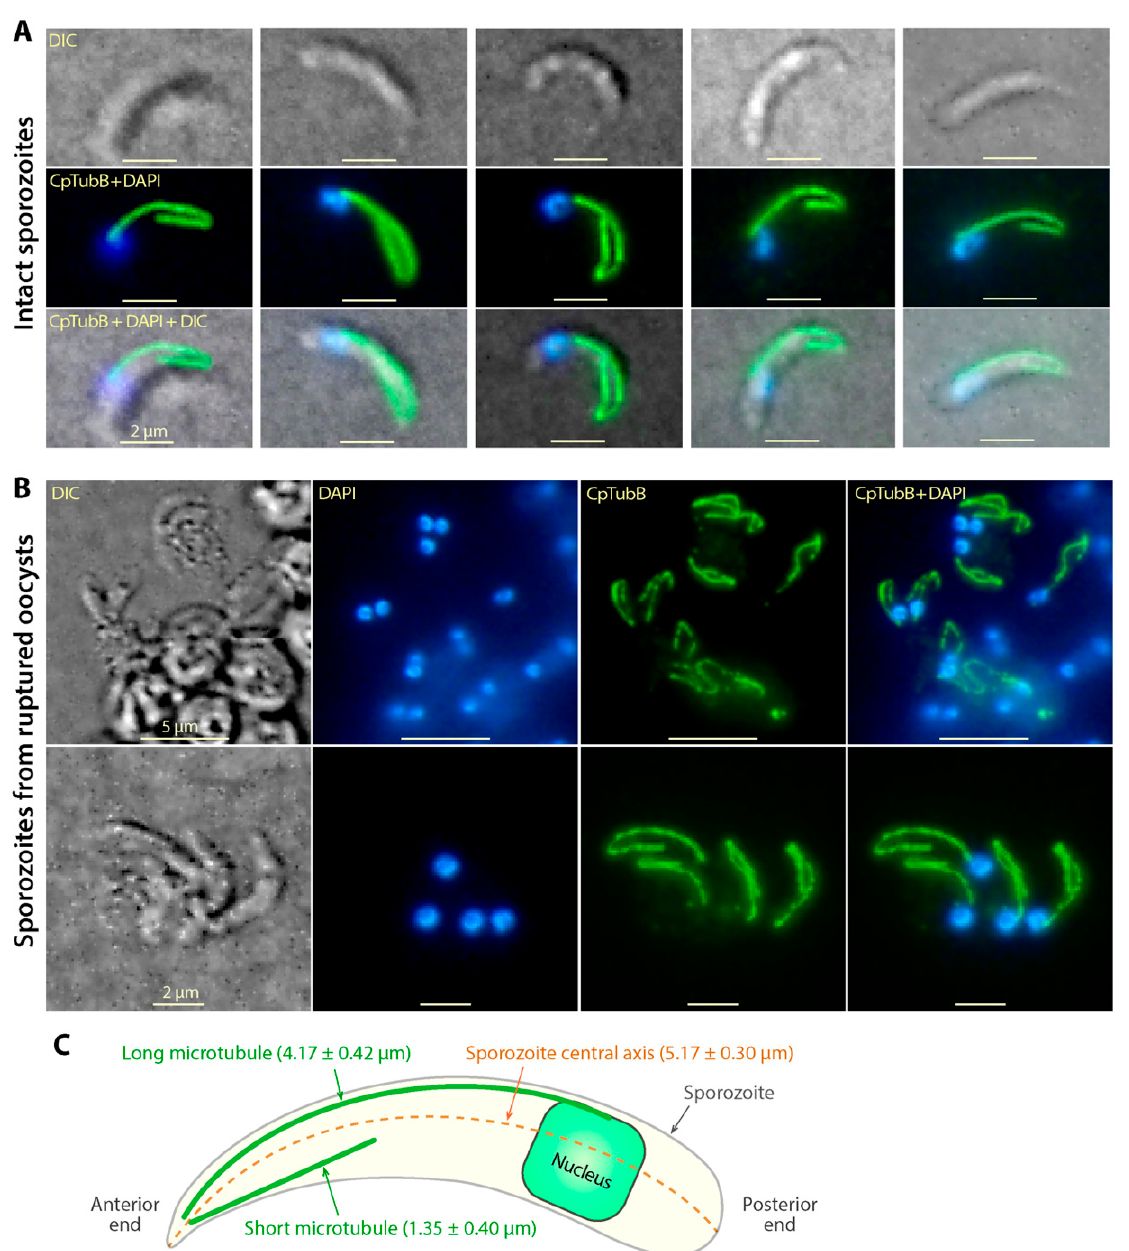
Figure 2. Indirect immunofluorescence assay (IFA) detection of tubulin-based structures in the sporozoites of Cryptosporidium parvum using affinity-purified anti-CpTubB antibody (green) and counterstained with 4 ′ ,6-diamidino-2-phenylindole (DAPI) (blue). ( A ) IFA of CpTubB in excysted intact sporozoites. ( B ) IFA of CpTubB in unexcysted sporozoites, in which anti-CpTubB antibody was only able to label sporozoites retrieved from oocysts after a freeze-and-thaw treatment. ( C ) Lengths of the excysted sporozoites (orange), long and short microtubules (green) ( n = 30). DIC, differential interference contrast microscopy.